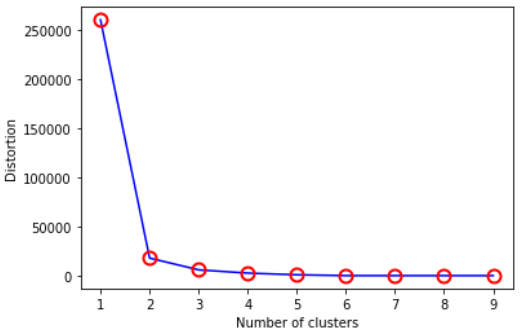
Figure 3. Finding optimal number of clusters. Table 4. Clustered dataset_1.